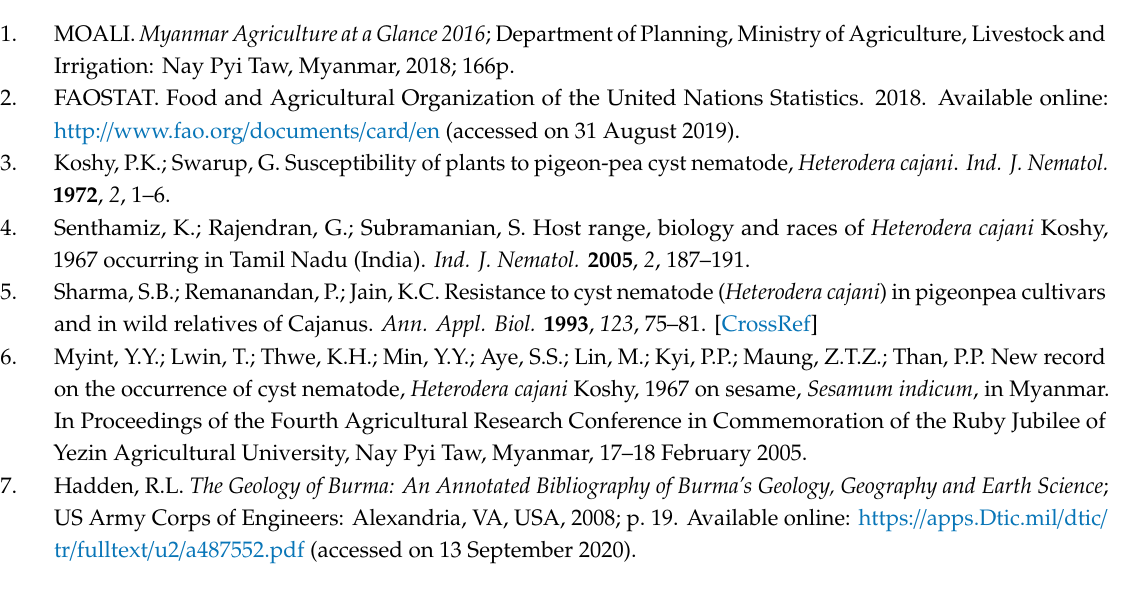
Table S1: Sequences of the real-time PCR primer sets used in this study. Figure S1: Phylogenic tree of Meloidogyne spp. (accession No.) based on the 18S rRNA sequences which are available in the NCBI Taxonomy database. Author Contributions: Y.Y.M. conceptualized; Y.Y.M., K.T., A.Y., conducted the experiments and collected field data; T.H.N.; assisted soil samplings; A.K.M.; provided local farmers information N.N.H.; Y.I. collected